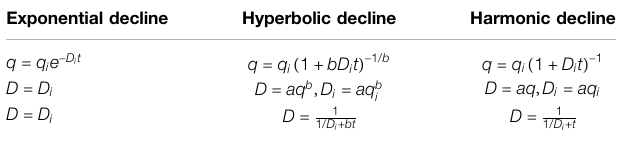
TABLE 1 | Exponential, hyperbolic, and harmonic equations from Arps (1945). Exponential decline Hyperbolic decline